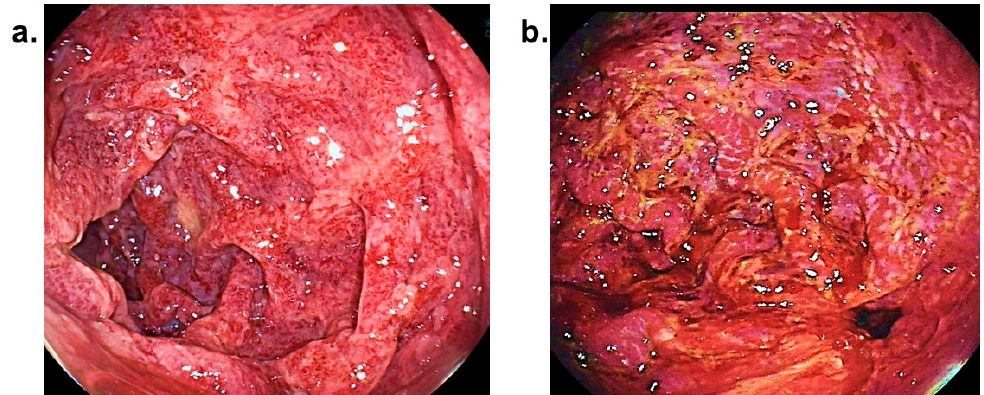
Figure 2. Images obtained during an oesophago-duodeno-gastroscopy of patient 2, showing ( a ) pronounced ischaemic changes of the mucous membranes of the gastric antrum and pylorus and ( b ) partial ischaemic, partial hyperaemic and partial infectious changes of the duodenal mucosa.